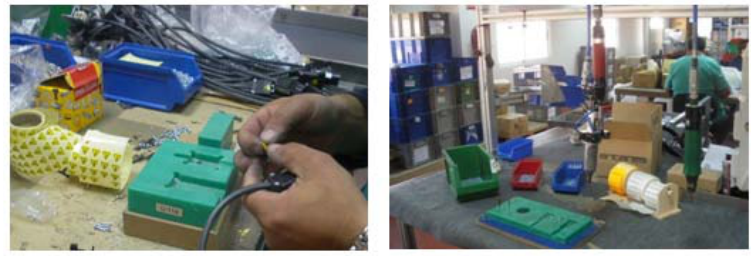
Figure 5. Former workplace (left), and actual workplace (right) including several